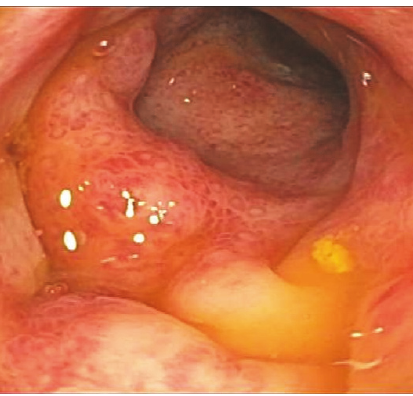
Figure 1: Endoscopic view of ulcerated mucosa with erythema and easy friability, suggestive of moderate colitis.